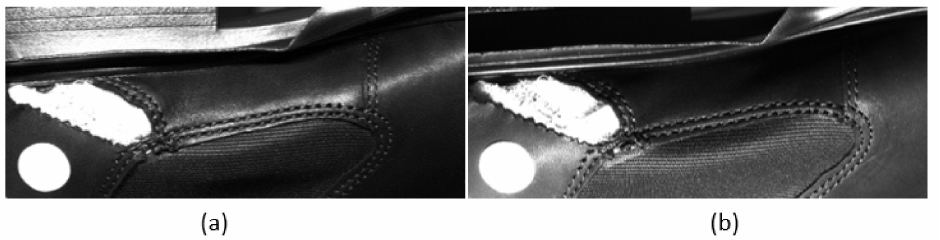
Figure 5. Demonstrating impact of position line 200 mm red light: (( a ) light source placed above, ( b ) light source placed